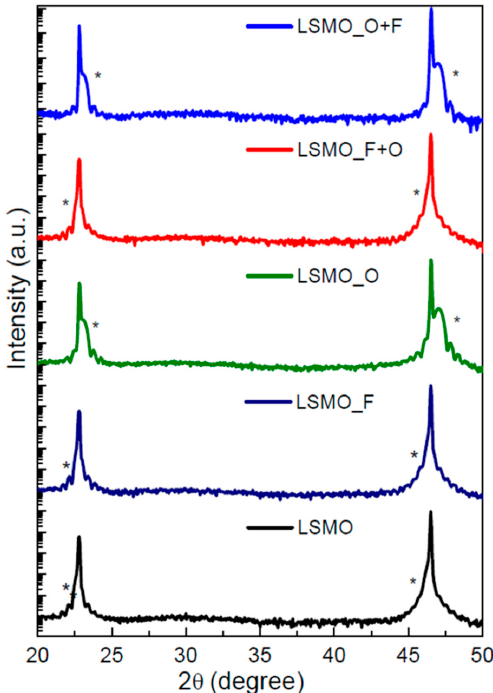
Figure 2. X-ray diffractograms of the treated LSMO thin films (where * denotes the LSMO film peaks).